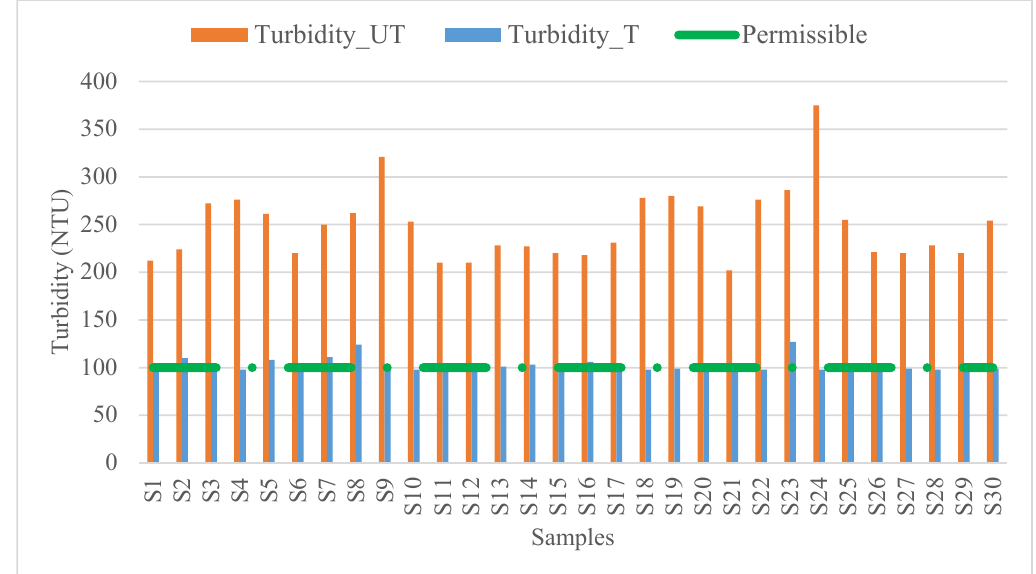
Figure 2. Turbidity of untreated (UT) and treated (T) samples and permissible limits.